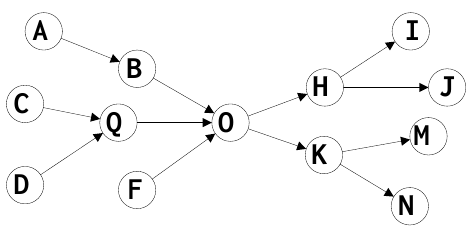
Figure 1. Path graph of an electronics supply chain.